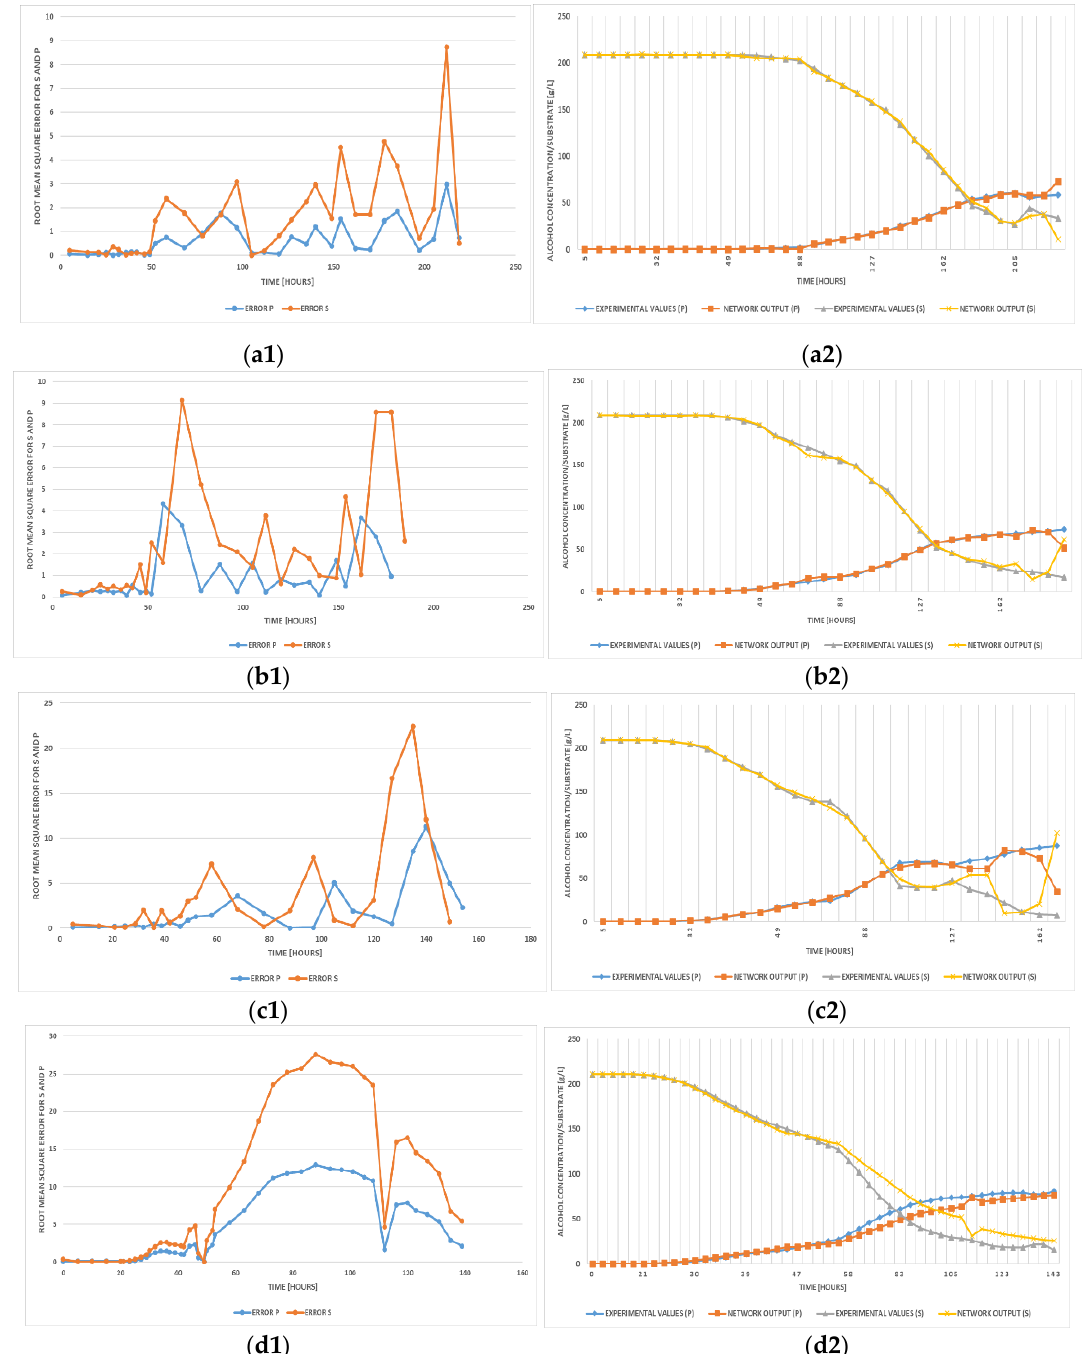
Figure 11. MSE ( a1 – d1 ) and generated results by the NN vs. experimental values ( a2 – d2 ) using the fourth variant input-output configuration of NN at 20, 24, 26 and 28 °C.